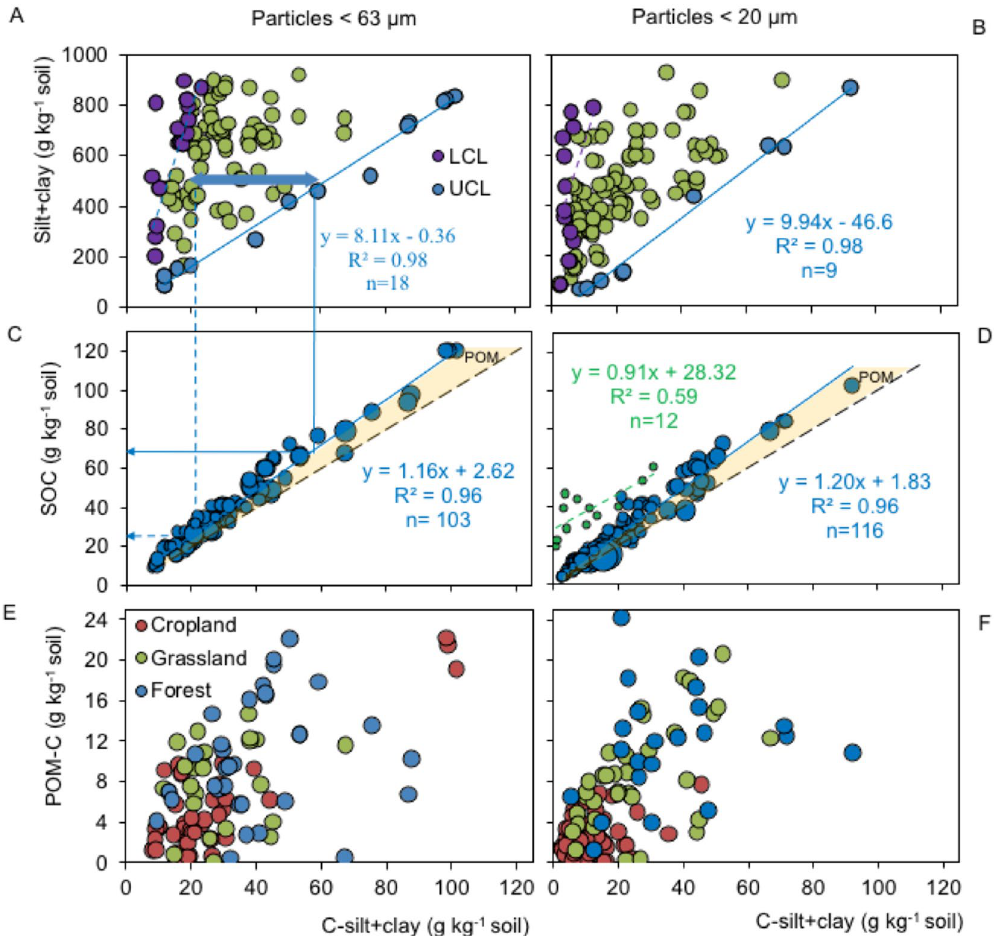
Figure 6. Soil organic carbon (SOC) sequestration potential. Dotted and solid arrows stand for low (LCL) and upper C level (UCL) distinguished by purple and blue data points respectively for the same soil textures along the common slope regression. Black segmented line stand for 1:1 line and blue solid line for fitted particles < 63-µm ( A , C ) and particles < 20-µm ( B , D ). Dutch dataset used by Hassink 23 to calculate the saturation is also shown ( D ). A similar relationship for particulate organic matter carbon (POM-C), the difference between SOC content and the C-silt + clay for paricles < 63-µm ( E ) and particles < 20-µm ( F